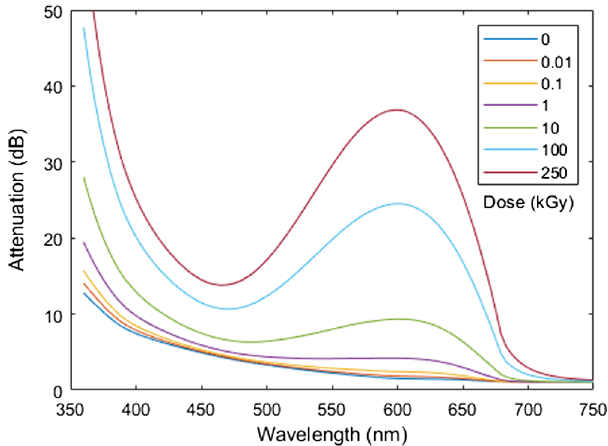
FIG. 6. Radiation-induced attenuation in a 200-m fiber irradi- ated over 10 m, for various doses in